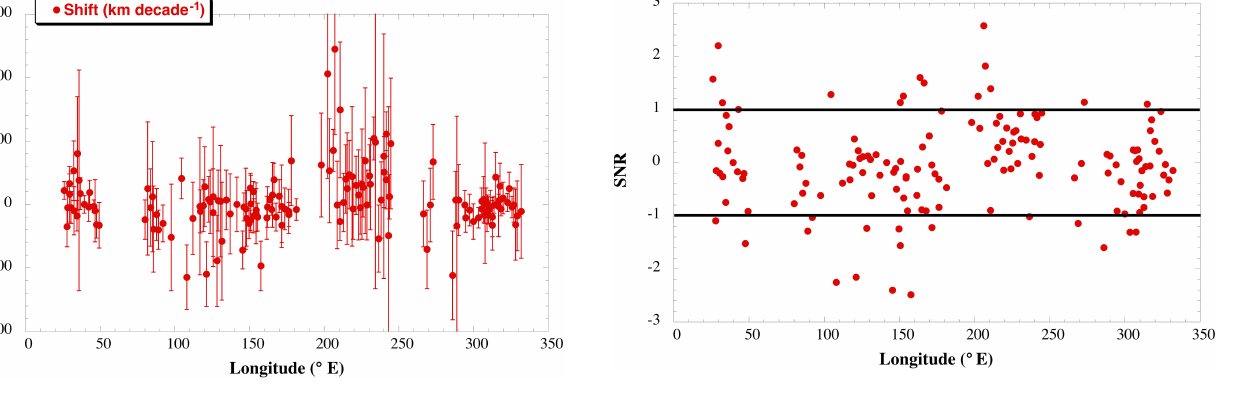
Figure 8. Estimated trend in the half-power point of CKE for each location shown in Figs. 6 and 7, as a function of latitude. Error bars represent the 90% confidence interval.